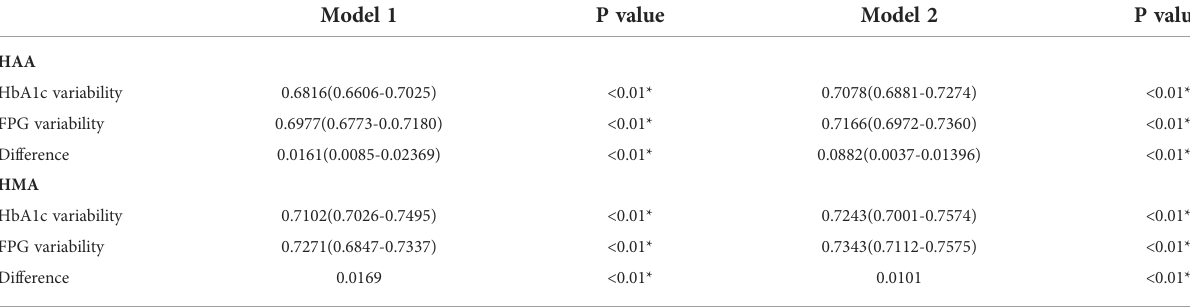
TABLE 3 Difference of Harrell ’ s C index between HbA1c variability and FPG variability in predicting